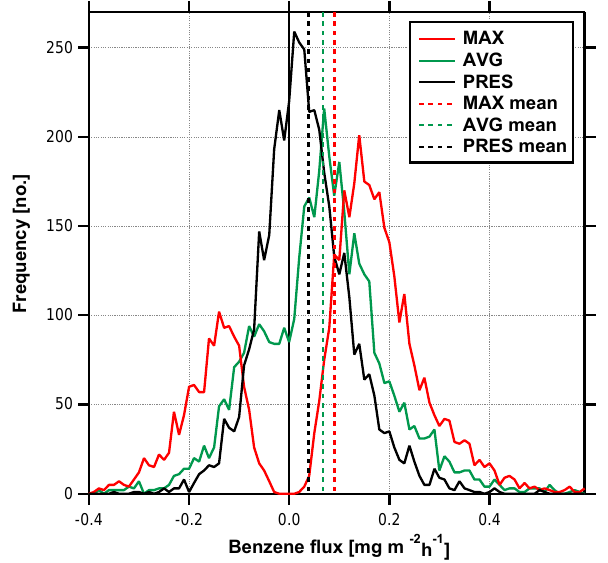
Figure 9. Distributions for benzene fluxes calculated using the MAX, AVG (5s) and PRES time-lag methods. The benzene concen- tration data had an average signal-to-noise ratio of 0.09 and ranged between 0.007 and 0.24 at the 5th and 95th percentiles.